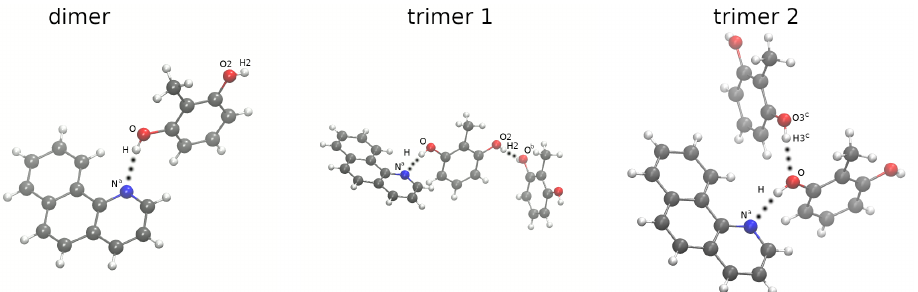
Figure 2. Model of dimer and trimers of benzo[h]quinoline-2-methylresorcinol for gas-phase CPMD simulations with atoms involved in the intermolecular hydrogen bonds formation. The atoms notation was prepared for the study and only atoms of interest are marked. Dotted lines indicate the presence of the intermolecular hydrogen bonds. Atom coloring scheme: grey—carbon atoms, red—oxygen atom, blue—nitrogen atom, white—hydrogen atom. The trimers are built from the crystal structure [9] taking the central 2-methylresorcinol as a reference and then generating the surrounding molecules using the symmetry codes a (x,y,z) for HBQ, b ( 1 − y, − 1 and c ( − 1 +x, 1 +z) for the O3 c -H3 c molecule of the trimer 2 2 2